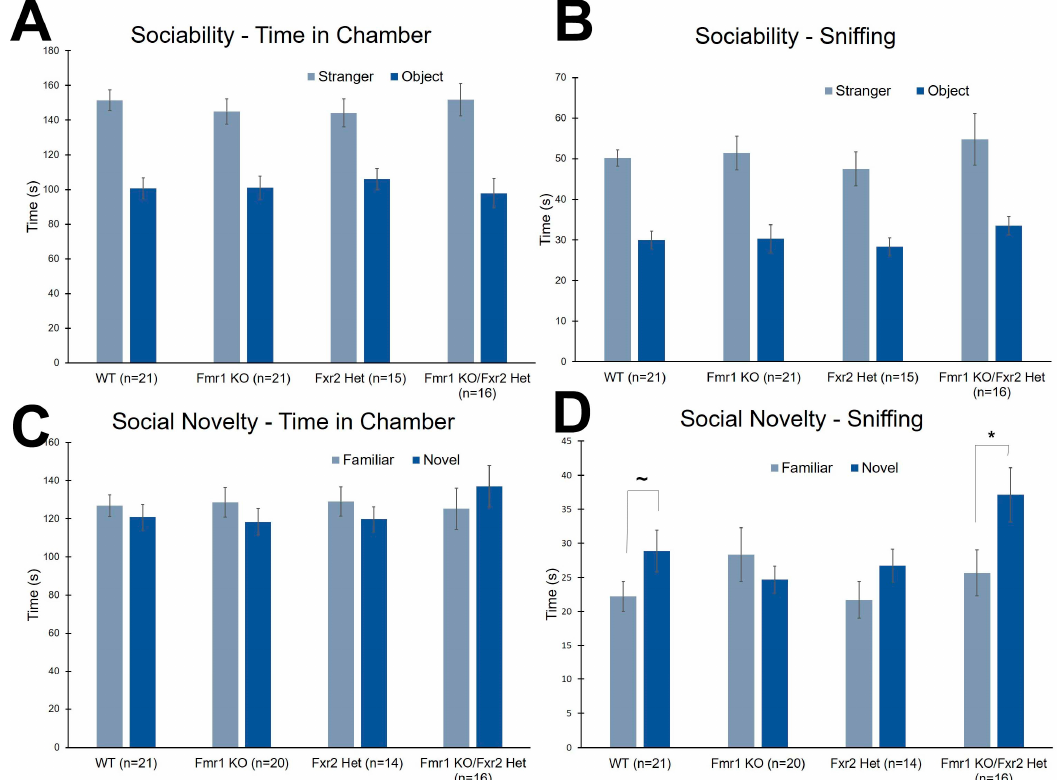
Figure 5. The three-chambered apparatus was used to assess social behavior. ( A ) In the sociability phase, there were no effects of genotype on time in chamber. All mice spent more time in the chamber with the stranger mouse compared to the chamber with the object. ( B ) In the sociability, phase, there were also no effects of genotype on time spent sniffing either the object or the stranger mouse. All mice sniffed the stranger mouse statistically significantly more than the object. ( C ) In the preference for social novelty phase, there were no effects of genotype on time in chamber. None of the four genotypes showed a preference for either the chamber with the novel mouse or the chamber with the familiar mouse. ( D ) In the preference for social novelty phase, there was a statistically significant genotype x chamber interaction for sniffing time ( p = 0.043). WT and Fmr1 KO/ Fxr2 Het mice spent more time sni ffi ng the novel mouse compared with the familiar mouse ( p = 0.062, and p = 0.006, respectively), whereas Fmr1 KO and Fxr2 Het mice did not. Each bar represents the mean ± SEM for the number of mice indicated on the figure. *, p < 0.05. ~, 0.05 ≤ p ≤